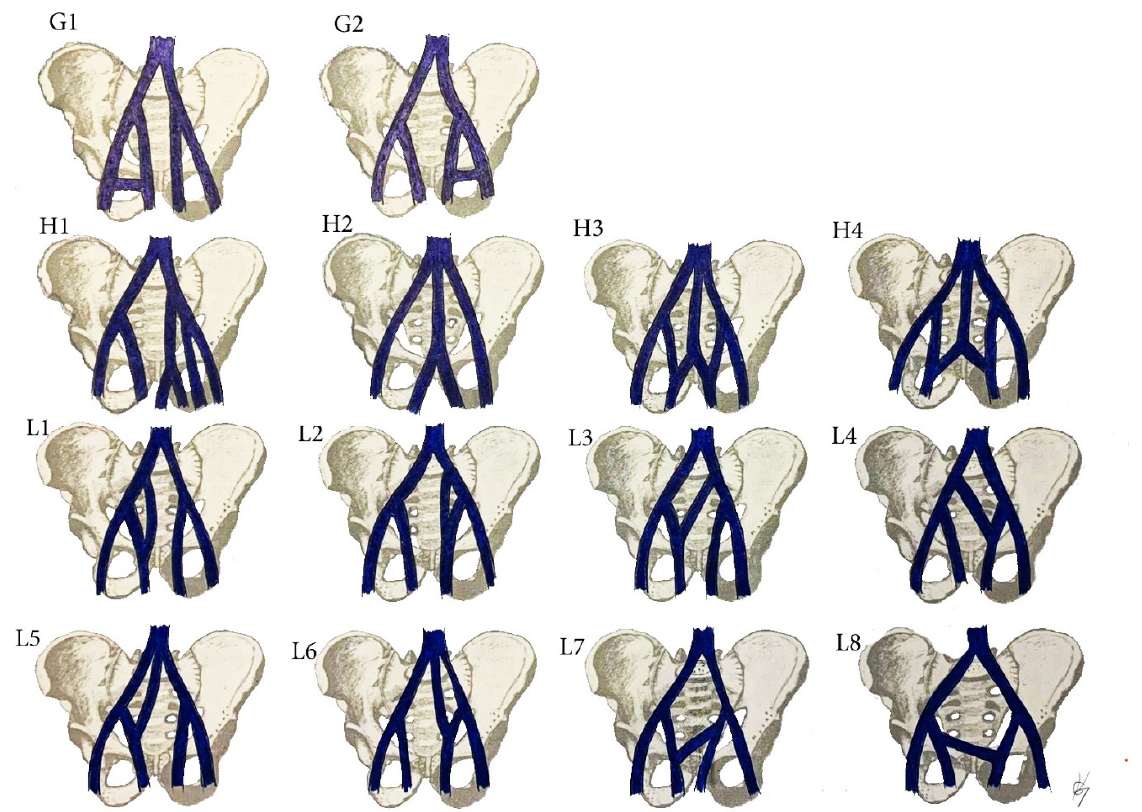
Figure 18. IIA variations. ( G1 ) Communication vein between the IIV and the EIV. ( H1 ) Separated trunk of bilateral internal iliac veins connecting with each other before draining into the left CIV. ( H2 ) The internal iliac veins form a common trunk, that drains into the inferior vena cava. ( H3 ) The internal iliac veins form a common trunk, which drains into the inferior vena cava, communication vein between the IIVs and ipsilateral EIV. ( H4 ) Both IIVs are joined by a connecting vein that drains into the IVC. ( L ) Communication veins. ( L1 , L2 ) Communication vein between the IIV and ipsilateral CIV. ( L3 , L4 ) communication vein between the IIV and contralateral CIV. ( L5 , L6 ) Both internal iliac veins are joined with a communication vein, which drains into the inferior vena cava. ( L7 , L8 ) Communicating vein between both IIVs. Variations ( G1 , L1 , L3 , L5 , L7 ) are related to right pelvic sidewall, whereas variations ( G2 , L2 , L4 , L6 , L8 ) are related to left pelvic sidewall.